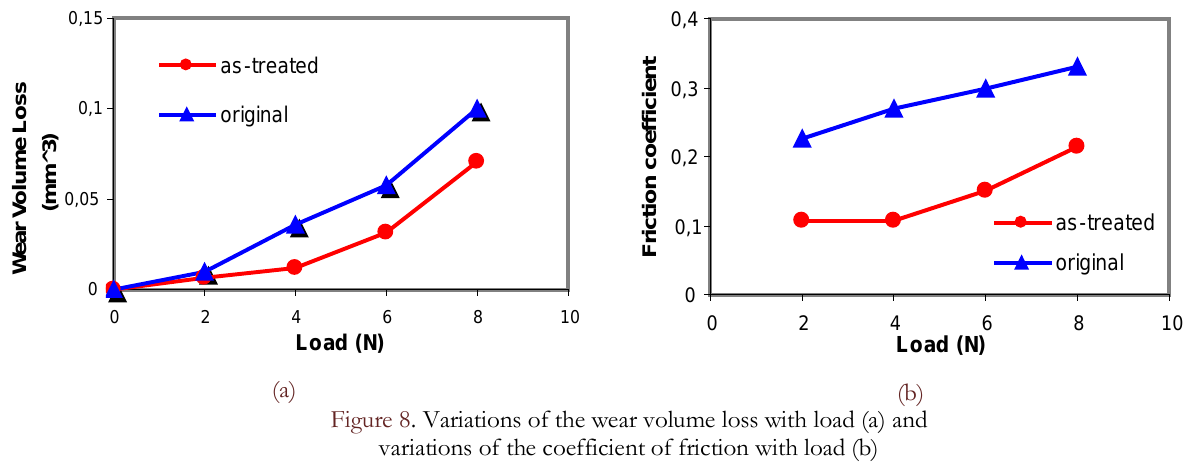
Figure 8. Variations of the wear volume loss with load (a) and variations of the coefficient of friction with load (b) for the SMAT and the original low-carbon steel samples